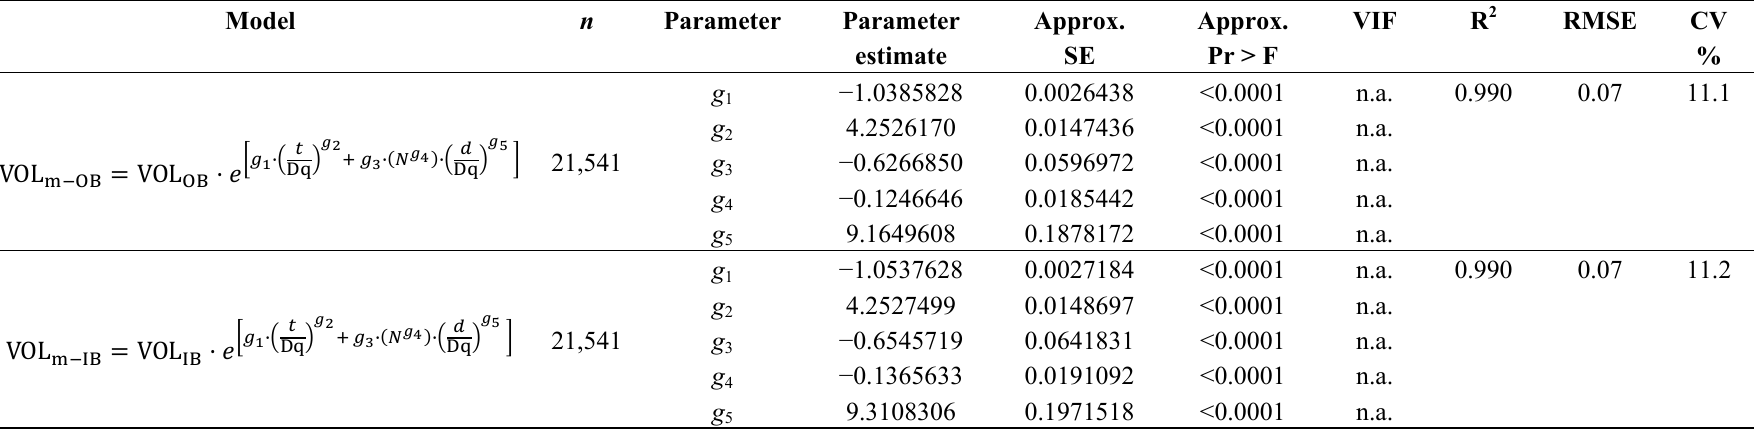
Model Parameter Parameter